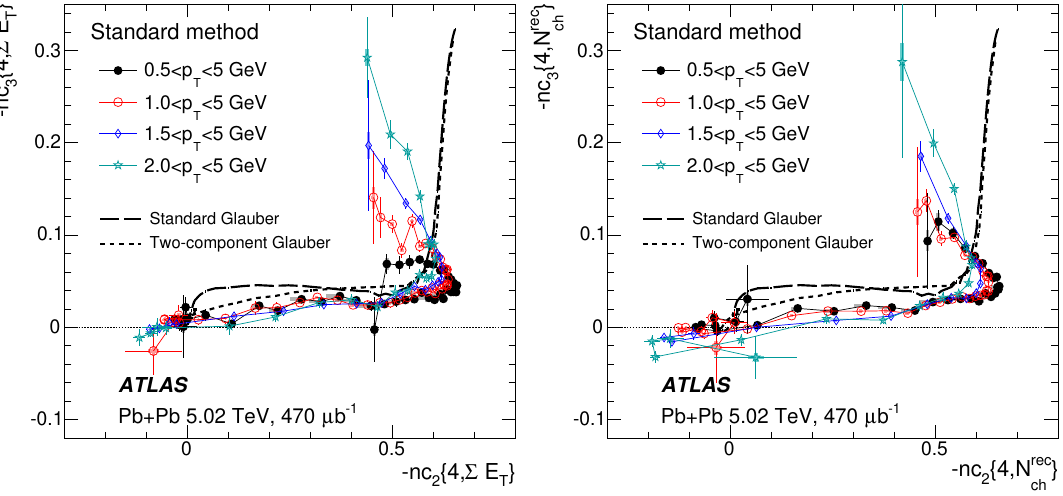
Figure 35 . The correlation between (cid:0) nc 3 f 4 g and (cid:0) nc 2 f 4 g compared with Glauber model predic- tions [41] in four p T ranges with event class based on (cid:6) E T (left panel) and N rec error bars and shaded boxes represent the statistical and systematic uncertainties, respectively.